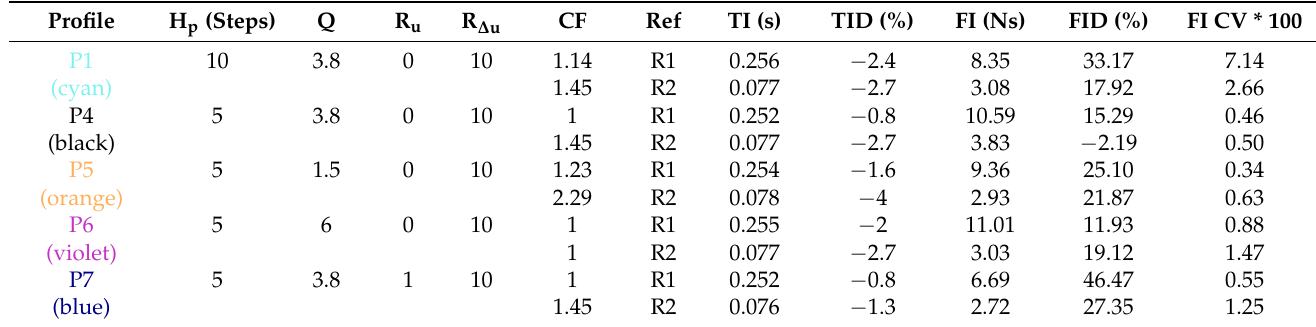
Table 5. HIL MPC tuned parameters and the resulting performance indices. The colors refer to the corresponding curves presented in Figures 5 and